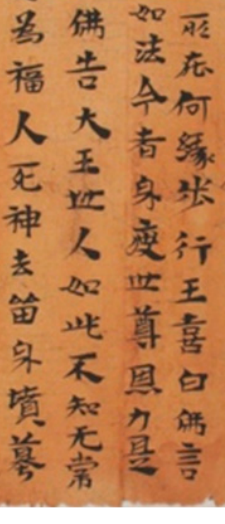
Figure 3. Pi-Yu Scripture.